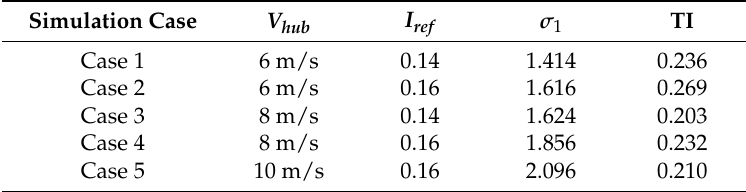
Table 3. Wind Speed Characteristics for Two Simulation